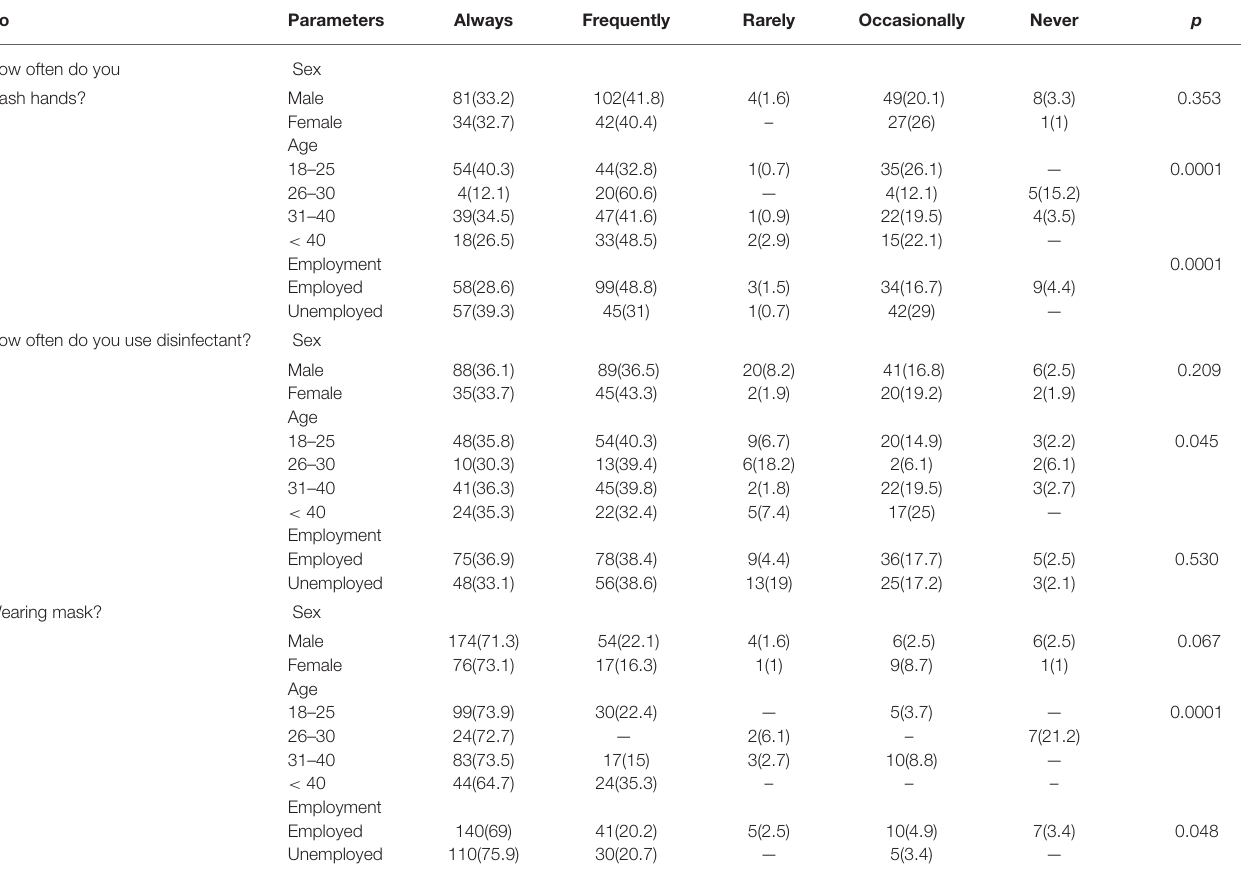
TABLE 5 | Association between demographics and COVID-19 preventative measures. No Parameters Always Frequently Rarely Occasionally Never